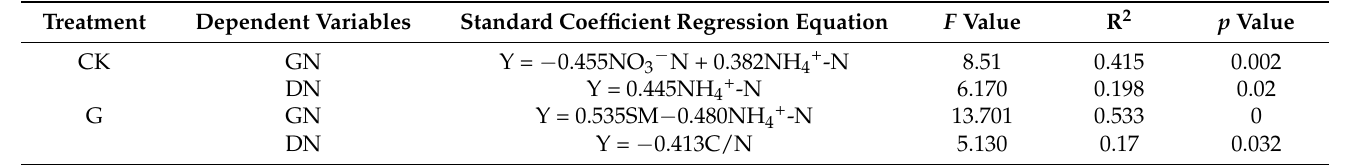
Figure 3. Relationships between gross nitrification (GN) and NH 4+ -N ( a ), NO 3 − -N ( b ), SOC/TN (C/N) ( c ), and soil moisture (SM) ( d ) in enclosure (CK) and heavy grazing (G) treatments, respectively. Relationships between denitrification (DN) and NH 4+ -N ( e ), NO 3 − -N ( f ), SOC/TN (C/N) ( g ), and soil moisture (SM) ( h ) in enclosure (CK) and heavy grazing (G) treatments, respectively. R 2 is the coefficient of determination. Table 2. Stepwise multiple regression analysis of the soil gross nitrification (GN) and denitrification (DN) rates against the measured soil parameters across the study sites. Treatment Dependent Variables Standard Coefficient Regression